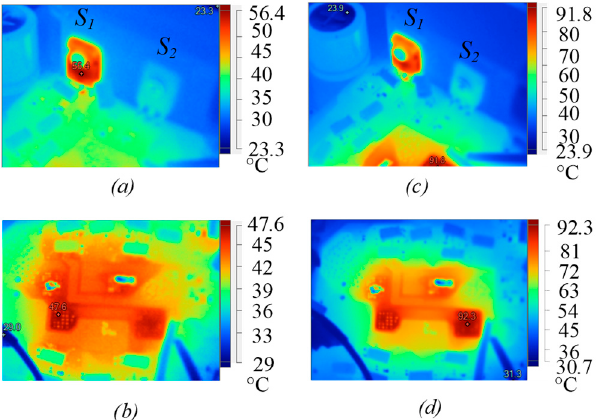
Figure 15. Efficiency study of the proposed solution in the unidirectional mode: thermal picture for 250 V and 550 W ( a , b ), and 350 V, 1150 W ( c , d ).